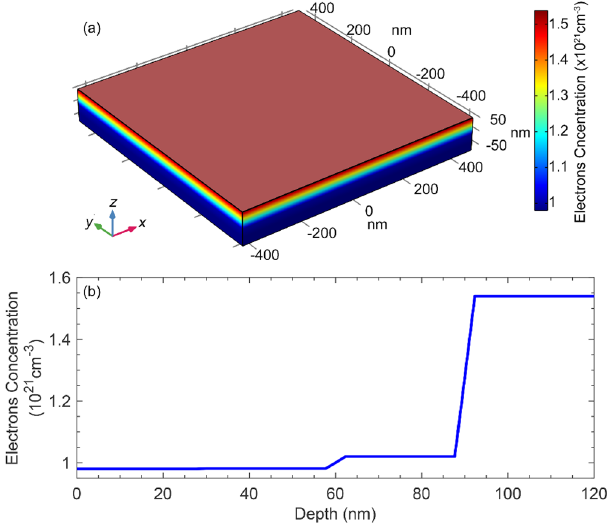
Figure 3. ( a ) 3D profile of the carrier concentration within a 900 × 900 × 120 nm AZO layer optically pumped at λ = 327.5 nm with the intensity of 2.41 mJ∙cm −2 , ( b ) The maximum carrier concentration within the depth of the AZO layer (i.e., along the z -axis).